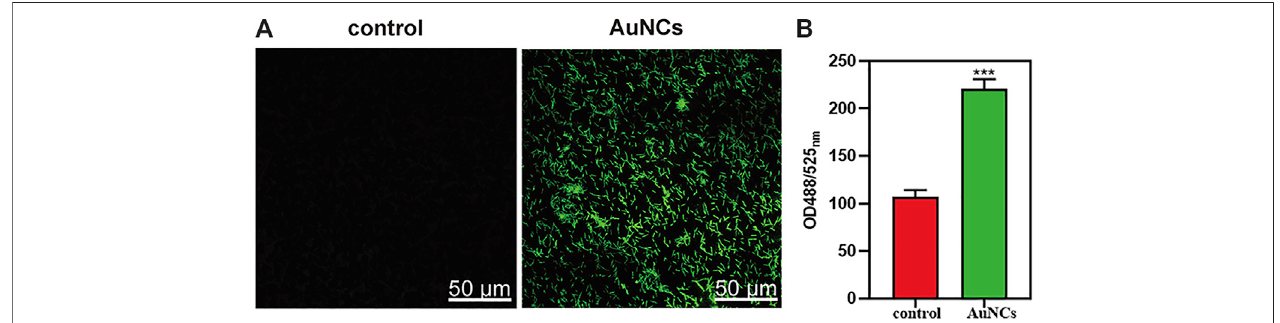
FIGURE5| ROSlevelsof F.nucleatum exposedtoAuNCs(0.2 mM)for2 h. (A) VisualizationofROSconcentrationin F.nucleatum exposedtoAuNCsbyconfocal microscope. (B) Quanti fi cation of ROS fl uorescence intensities in F. nucleatum at OD488/525 nm. (***P <